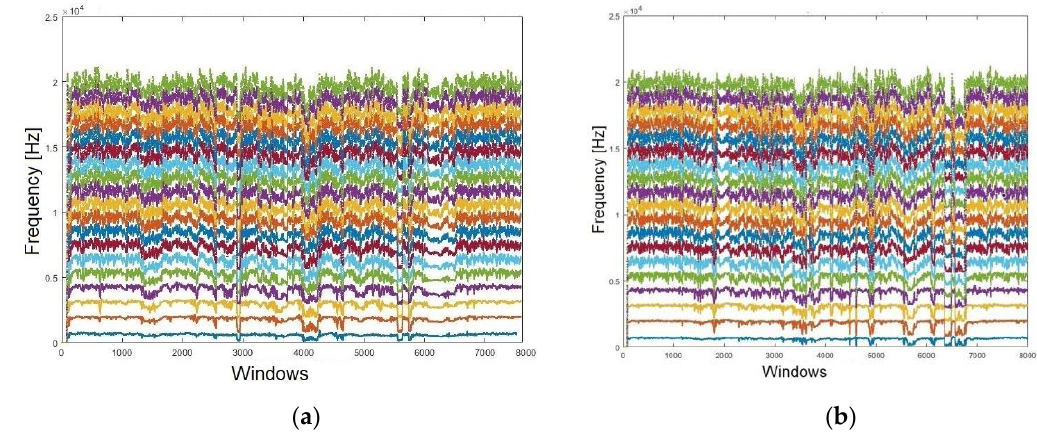
Figure 6. Smoothing the formants using an MAV filter for: (a) confronted audio; (b) reference audio.